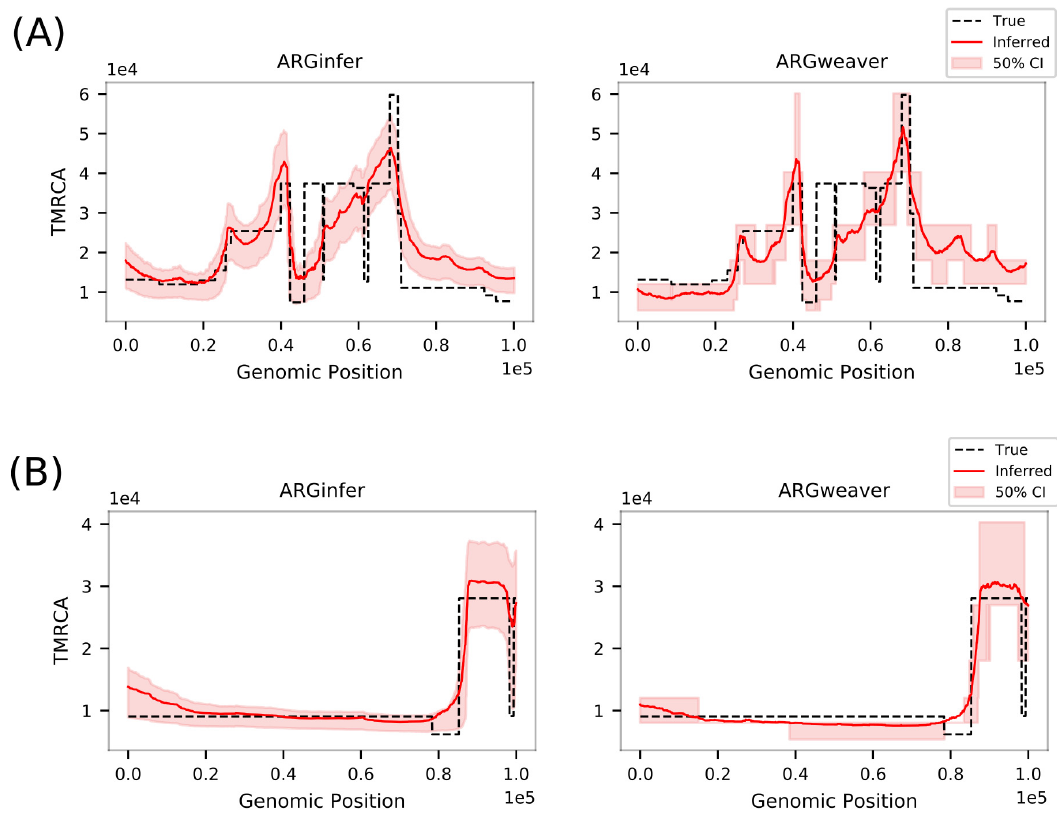
Fig 5. True (black dashed line) TMRCA, in units of 10 4 generations, and posterior mean (red line) inferred by ARGinfer (left) and ARGweaver (right) for randomly-selected, simulated data sets. (A) R = 1, (B) R = 4, and red shading shows 50% credible